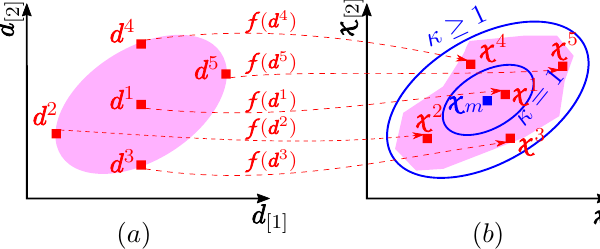
1 Figure 1. Principles of the unscented transformation. ( a ) Confidence region of the uncertain parameters